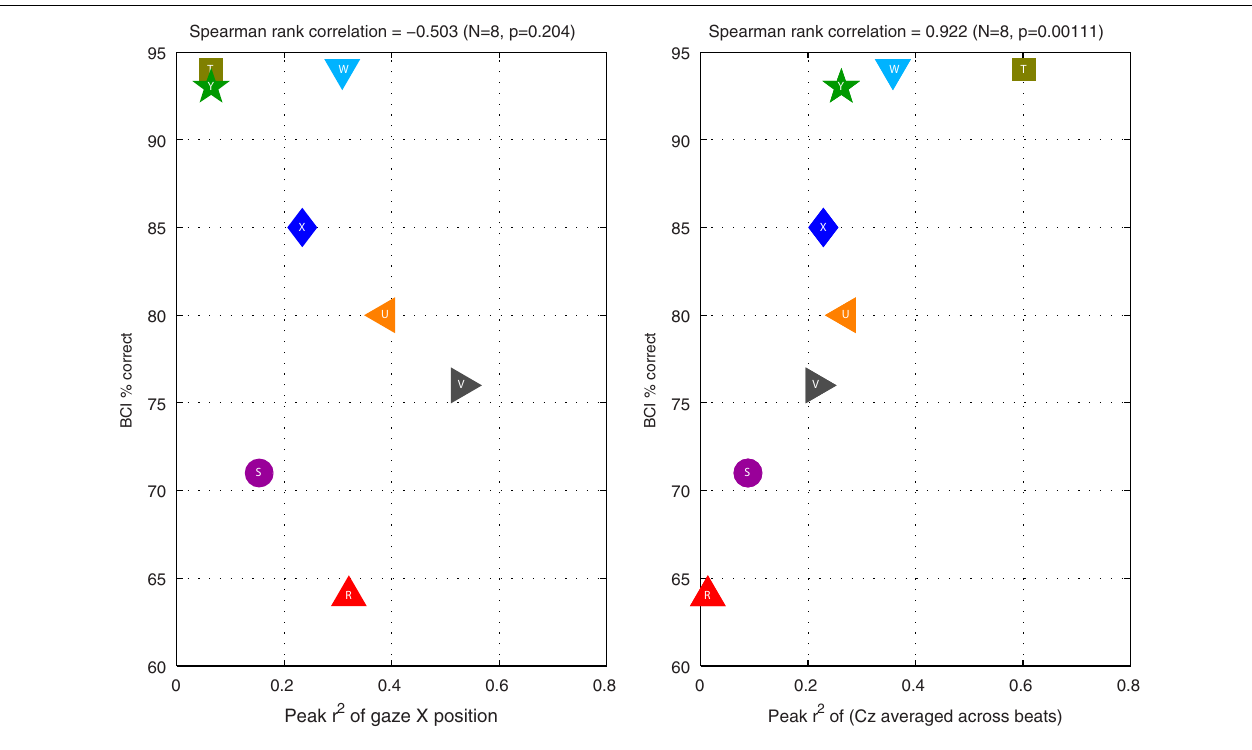
dashed lines in the third column of subplots in Figure 6 ).The right graph shows performance as a function of the peak r 2 of the preprocessed EEG at Cz (corresponding to the green horizontal dashed lines in the fourth column of graphs in Figure 6